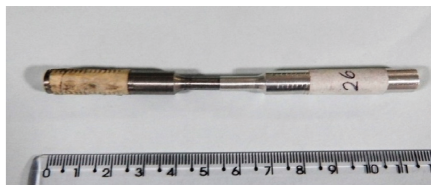
Figure 3: Machined test body for tensile